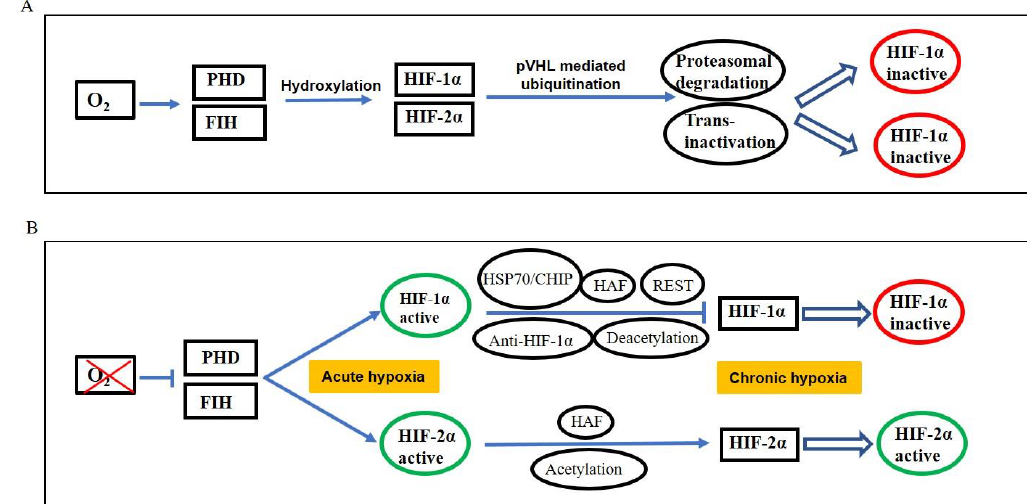
Figure 1. Oxygen-dependent regulation of hypoxia inducible factors HIF- 1α and HIF - 2α. ( A ) In presence of oxygen, HIF- 1α and HIF - 2α are hydroxylated by prolyl hydroxylase domains (PHDs) and FIH (Factor Inhibiting HIF-1), and then targeted for proteasomal degradation mediated by VHL protein. ( B ) Under acute hypoxia, both HIF- 1α and HIF - 2α are stabilized. Under chronic hypoxia, HIF- 2α is stabilized while HIF - 1α is downregulated.